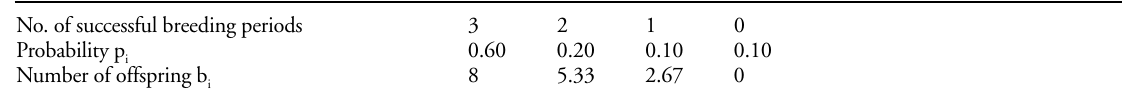
Reproductive parameters